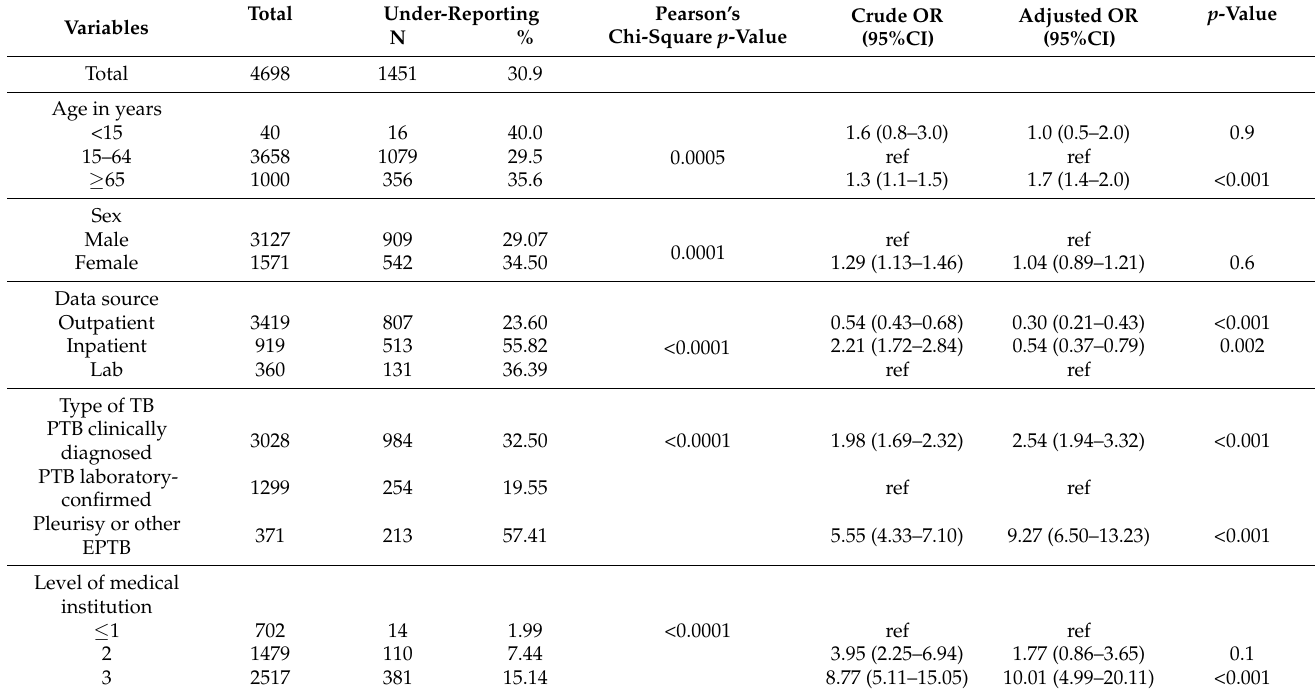
Table 4. Factors associated with under-reporting to TBIMS among diagnosed TB patients in six counties in